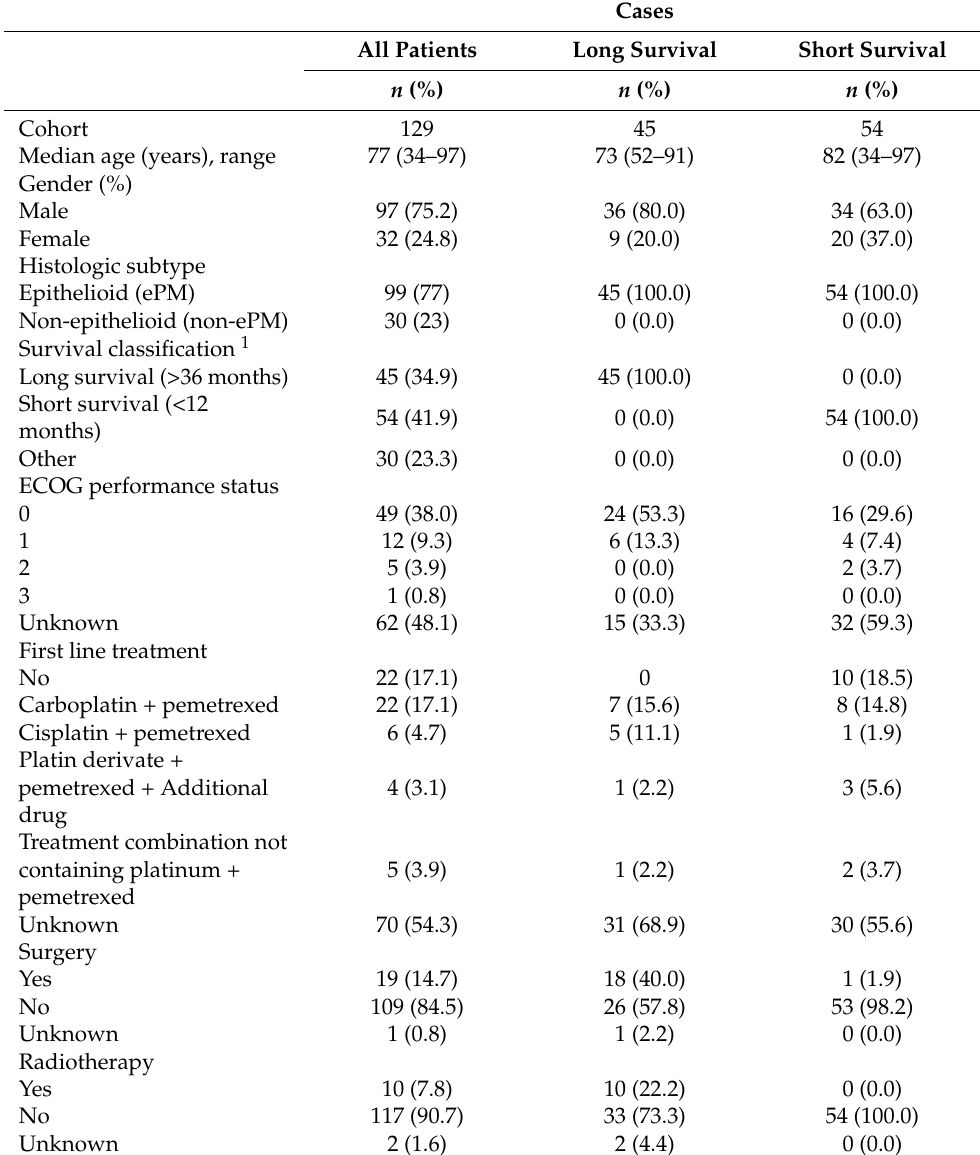
Table 1. Clinical data of the pleural mesothelioma (PM)